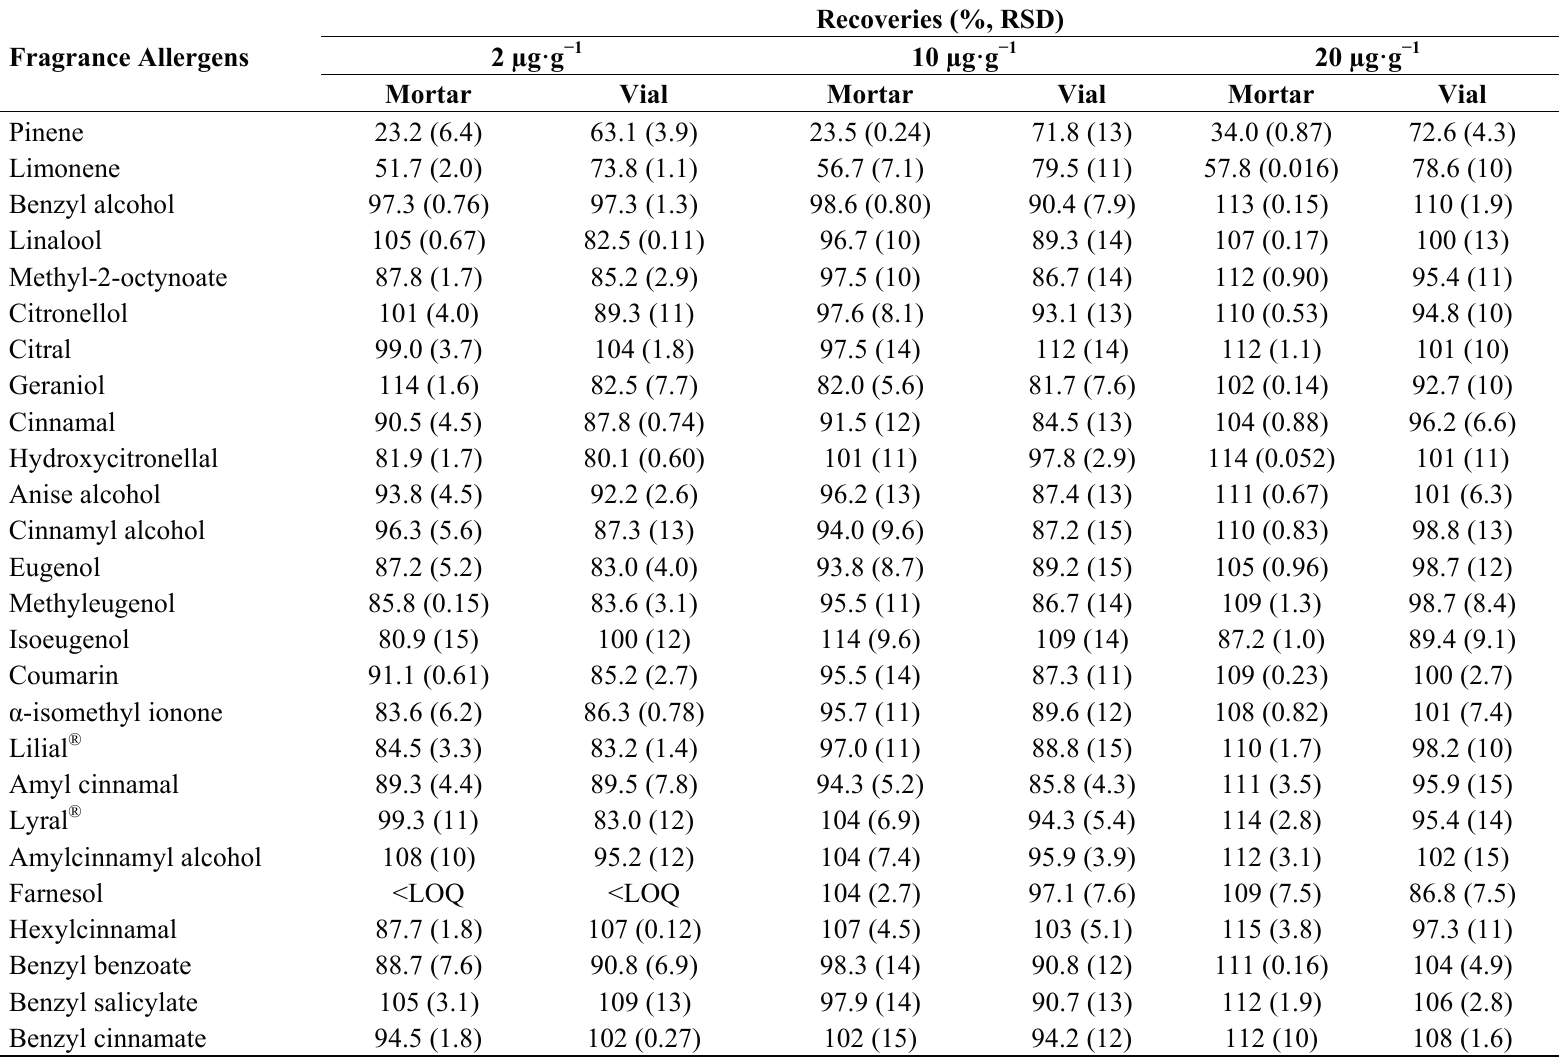
Table 4. Recoveries of fragrance allergens, preservatives, plasticizers and musks in a leave-on sample (regenerating cream) fortified at three concentration levels, analyzed by the proposed method